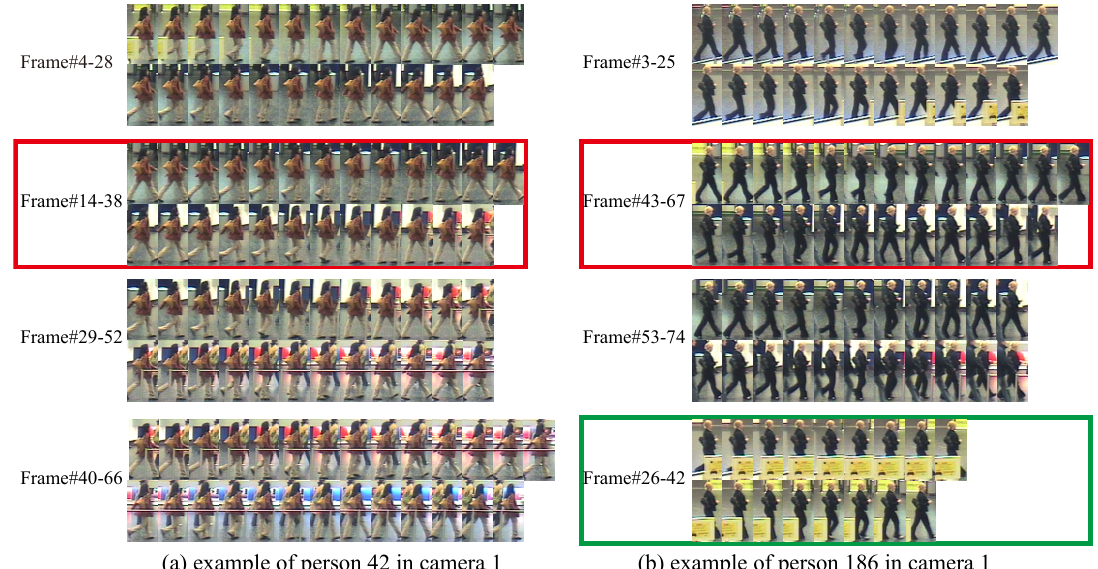
Figure 10. Two examples of selected walking cycles on iLIDS-VID. The candidate walking cycles for each video is presented, and the “best” walking cycle we selected is indicated by the red bounding box. Note that the image sequence in the green bounding box in ( b ) is not a candidate walking cycle. The frame indexes are given on the left side of the corresponding image